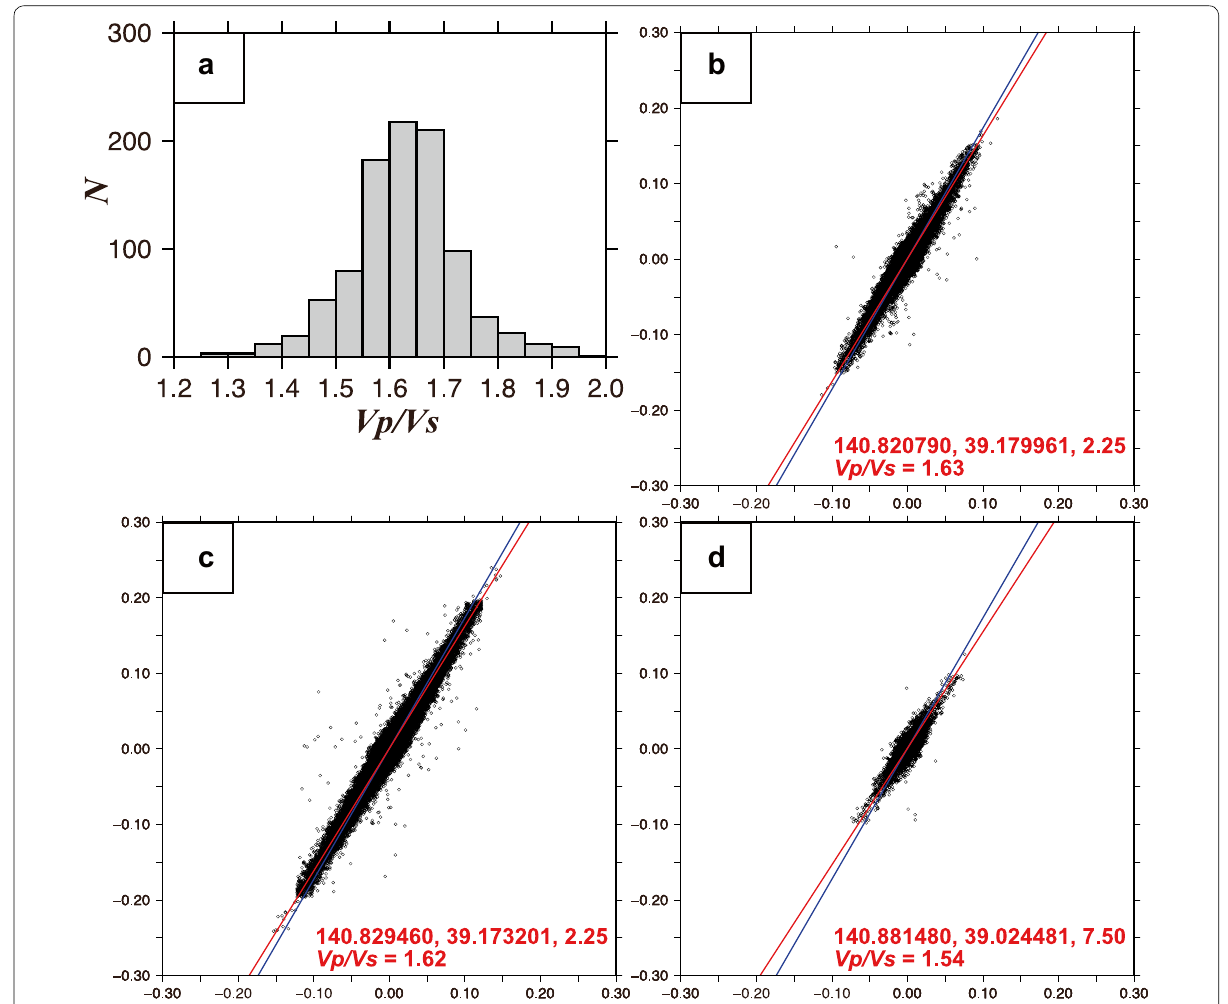
Fig. 6 a Histogram of V p /V s ratios estimated in this study and b – d examples of the data distributions. Slope of the red line represents the local V p /V s ratio for the cluster. Blue line is drawn as a reference whose slope is 1.73. Red texts represent the center of the longitude, latitude and depth ranges, and V p /V s ratio for the corresponding